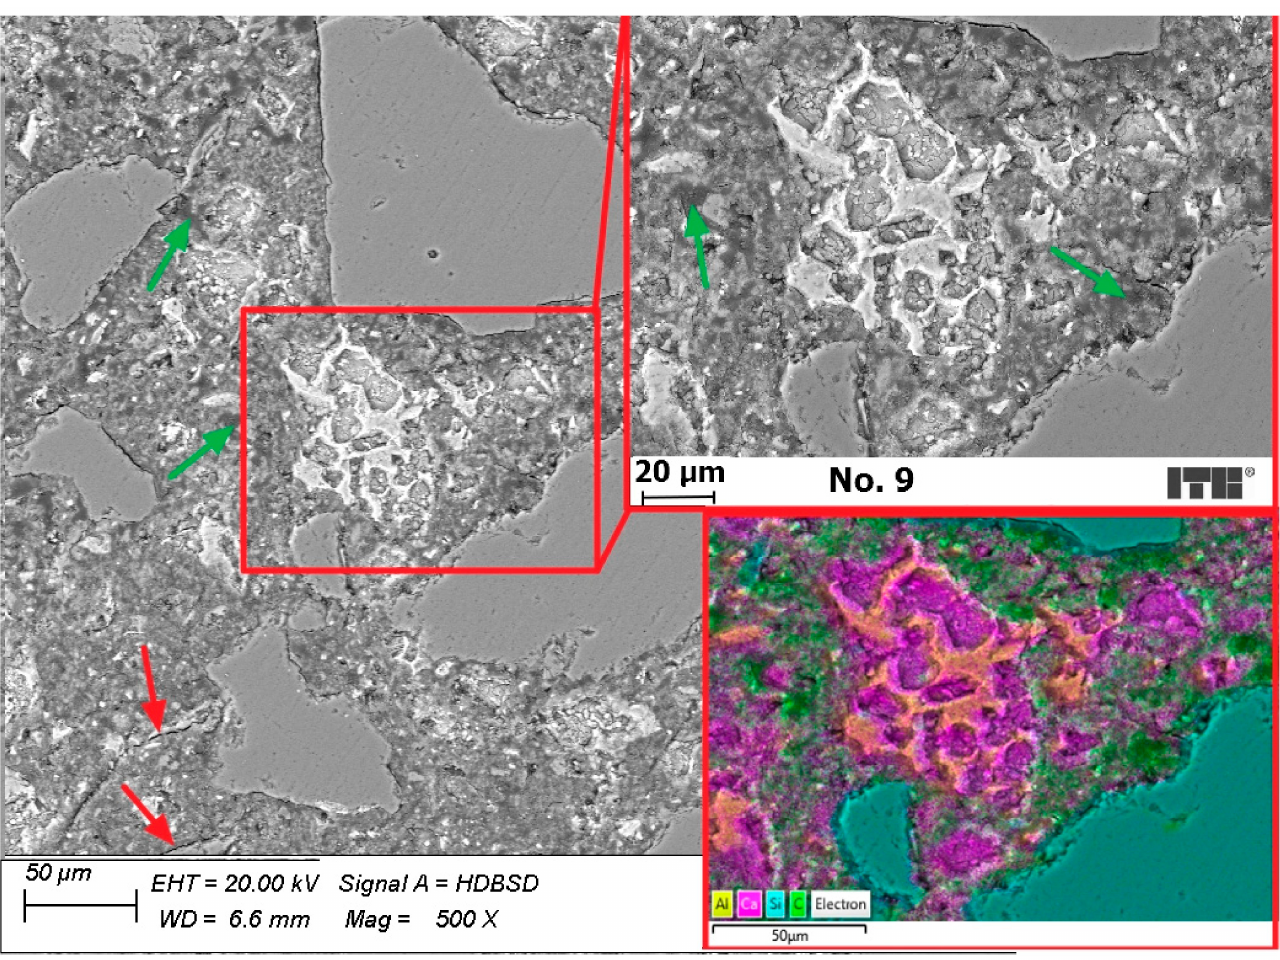
Figure 11. Mortar cured with product No. 9 (red arrows—cracks, green arrows—air